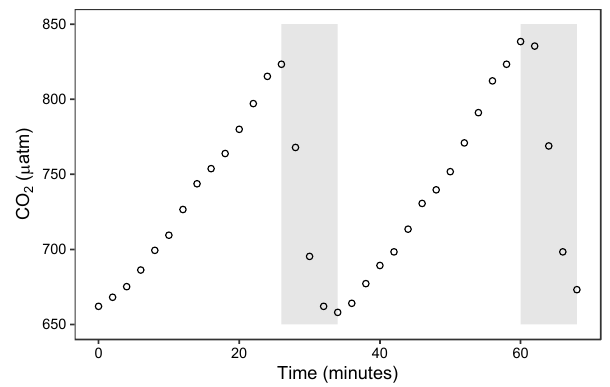
Figure 2. Example illustrating the chamber headspace CO 2 partial pressure ( y axis, µatm) during two pause and pulse (grey boxes) cy- cles. Data from a field deployment (22 September) in the described system with a 2min logging